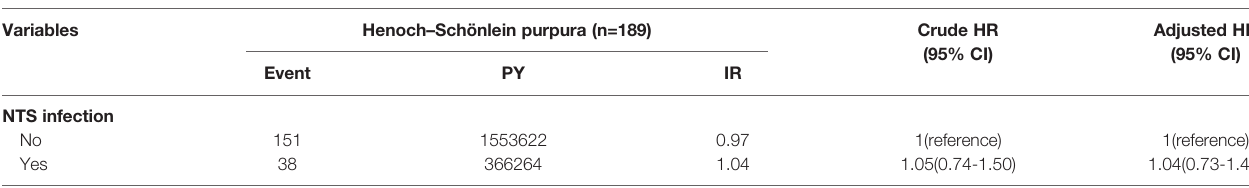
TABLE 6 | Alternative outcome